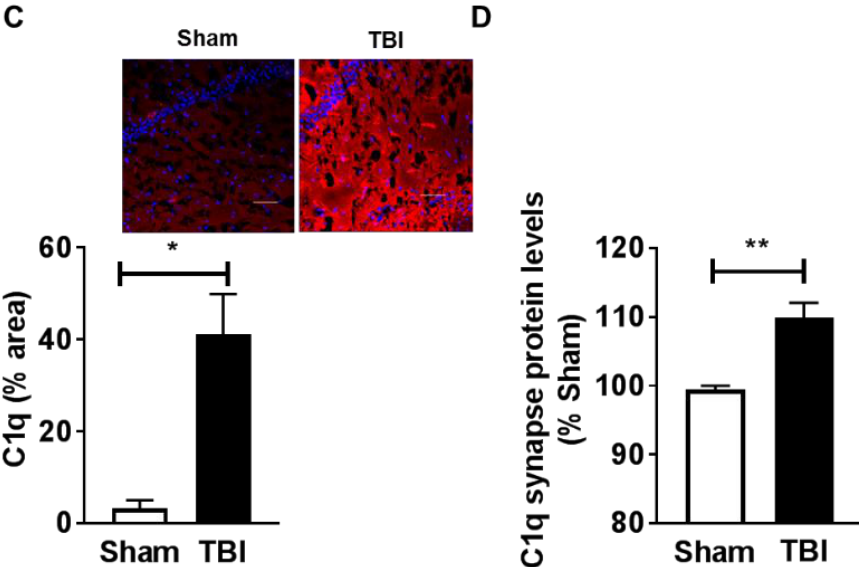
Figure 4. Contusion injury induces robust complement initiation in the aged brain. Complement initiation components ( A ) C1q and ( B ) C3 gene-expression changes in the hippocampus of aged animals were measured by qPCR analysis, comparing expression levels between sham animals, and those 17, 14, and 30 days post injury. Both C1q and C3 expression levels were increased after injury. One-way ANOVA revealed significant differences (C1q-F = 15.89; p < 0.0001; C3-F = 50.58; p < 0.0001). Bonferroni post hoc test revealed differences between groups; n = 4–6/group. ( C ) C1q protein expression was measured by immunohistochemical staining in the dorsal hippocampus. Representative images from sham and TBI (30 dpi) animals (inset, in red C1q staining and in blue cell body counterstaining). C1q protein expression increased chronically after injury. No reactivity was observed in secondary alone. White scale bar = 50 µ m; 200 × magnification; n = 4–6/group. ( D ) Hippocampi were collected and synaptosomes were isolated by sucrose gradient followed by size calibration beads. C1q co-localization of synapse was measured by antibody staining. TBI (30 dpi) significantly increases C1q accumulation at synapse when compared with sham animals. Student’s t -test with Welch’s correction was used to measure differences between groups; n = 6/group. Bars depict group means and SEM; * p < 0.05, ** p < 0.01, *** p <